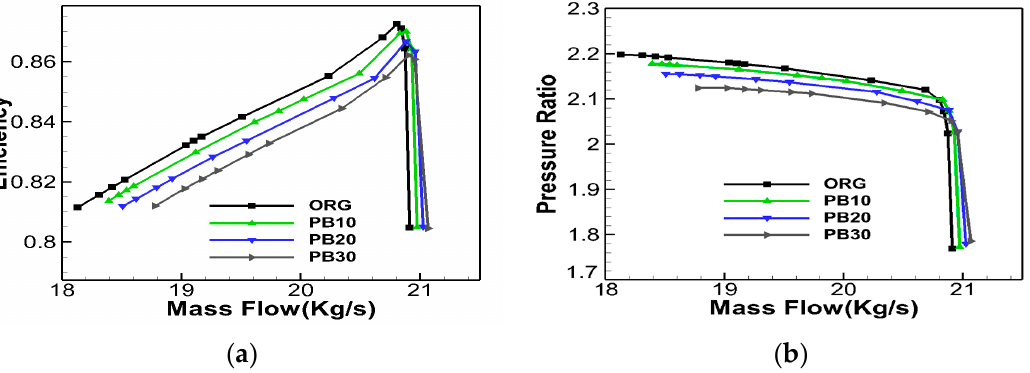
Figure 15. Comparison of isentropic efficiency and total pressure ratio of PB10, PB20, and PB30. ( a ) the isentropic efficiency. ( b ) the total pressure ratio. Table 4. Comparison of design point performance and stall margin of PB10, PB20, and PB30.